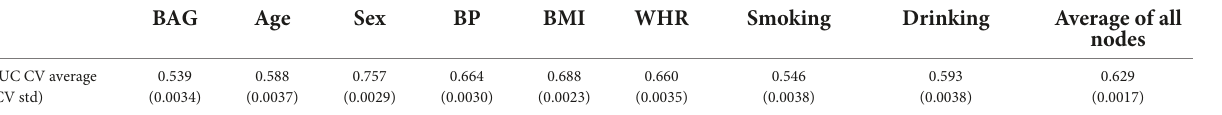
TABLE 2 Area under the ROC curve (AUC) for all model nodes.